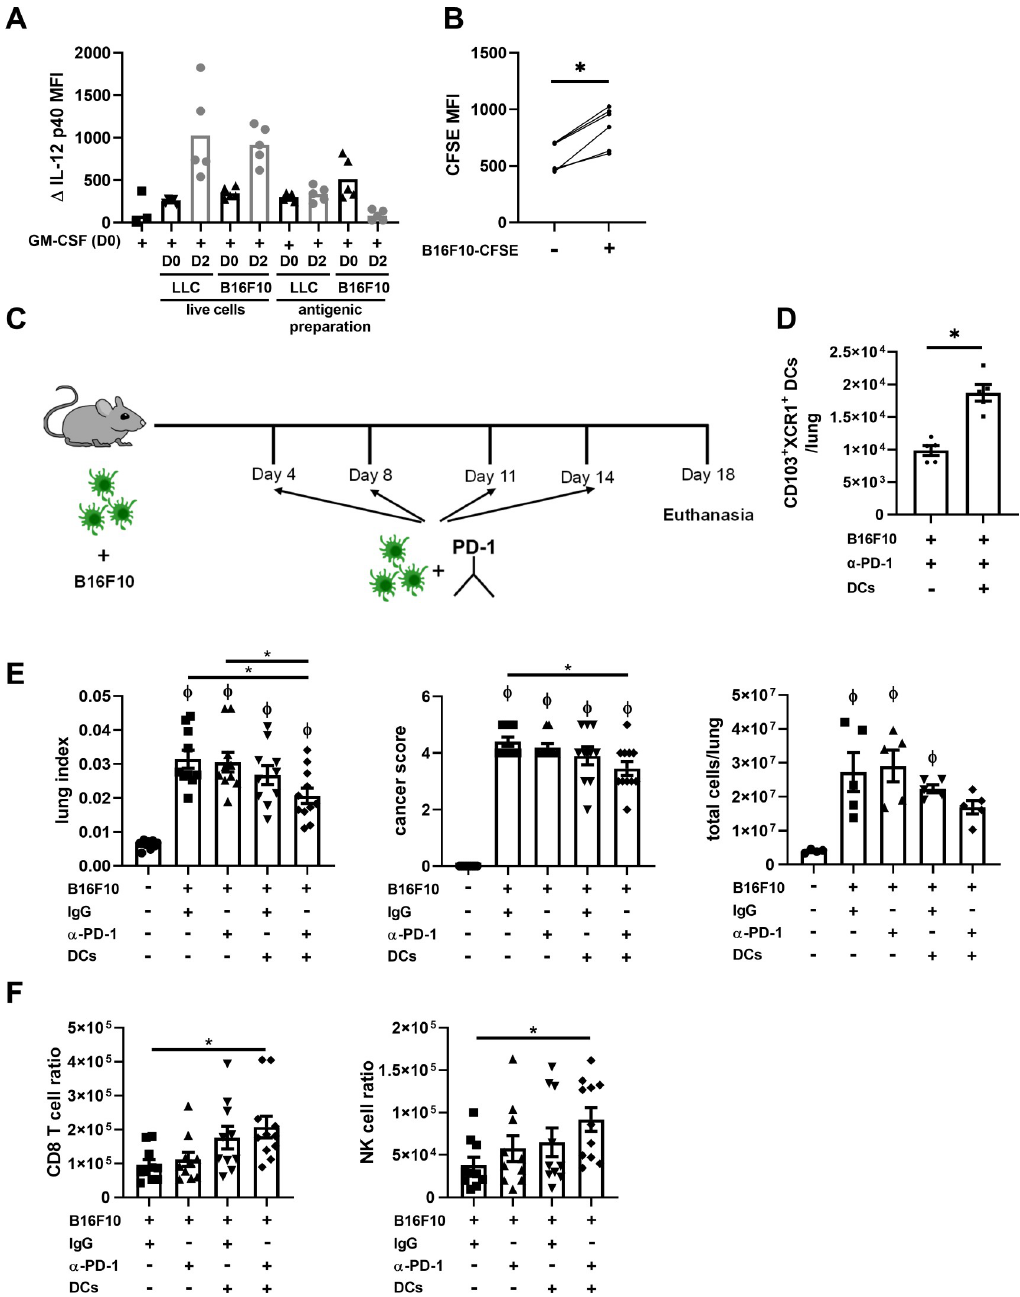
Fig 7. Injection of XCR1 + DC1 improves sensitivity to anti-PD-1 treatment. (A) FLT3L-BMDCs were stimulated with GM-CSF (Day 0). Either live B16F10/ LLC cells or a B16F10/ LLC antigenic preparation was added on day 0 or day 2 and Δ IL- 12 p40 MFI was measured by flow cytometry on day 3. (B) Two days following GM-CSF stimulation FLT3L-BMDCs were stimulated for 24h with CFSE-treated B16F10 cells and CFSE MFI was measured by flow cytometry in CD11c + MHC II + DC ± stimulation with CFSE-B16F10. (C) Schematic representation of the timeline treatment with the anti-PD-1 and XCR1 + DC1 injections (D-E-F) Analysis of mice lungs (D) 9 days or (E-F) 18 days after B16F10 injections. (D) The total number of lung CD103 + XCR1 + DC1 24h after the last DC injection. (E) Lung index (lung weight/mice weight), cancer score (indicative of the number and size of tumors) and lung total cell number. (F) Lung ratios of CD8 T cell and NK cell numbers relative to the number and size of tumors (cancer score). CD8 T cells were identified as CD45 + , CD19 - , CD90.2 + , CD4 - , CD8 + and NK cells were identified as CD19 - , CD3e - , B220 - , CD49b + , NK1.1 + by flow cytometry analysis. (A) Data are presented as individual dots with means. (B to F) Data are expressed as mean ± SEM. (A-B-E-F, except E panel 3) n = 5–11 pooled from two independent experiments. (D, E panel 3) n = 5 representative of two independent experiments. � = p < 0.05, compared as indicated in the graph; ϕ = p < 0.05 compared to na ï ve mice. P-values were determined using (B) paired t-test, (D) unpaired t-test and (E-F) one-way ANOVA followed by Tukey’s multiple comparisons test.